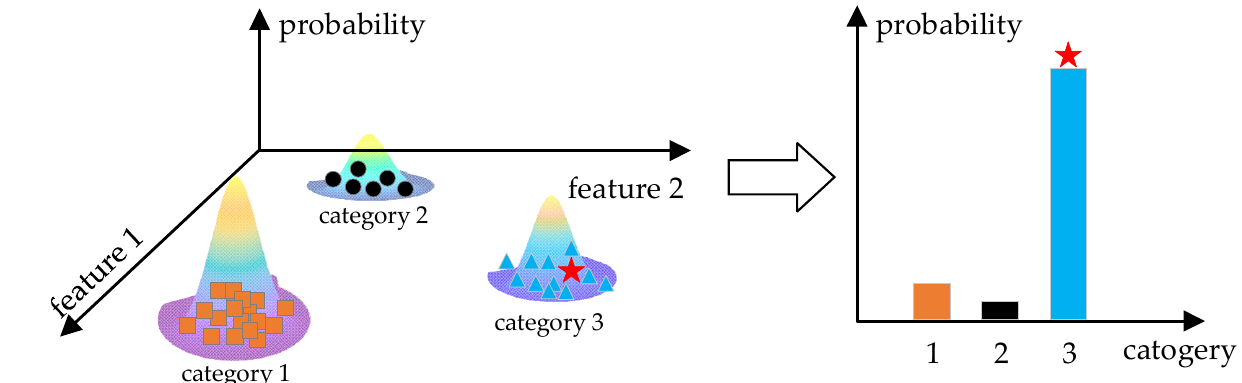
Figure 14. Gaussian mixture model classification presented in 2-dimensional form.